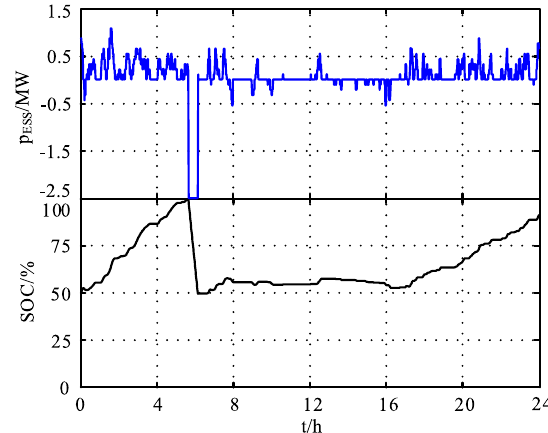
Fig. 4 Variations of the Li-ion ESS charge-discharge power and the SOC in a typical day (frequency regulation dead band is 50 ± 0. 04